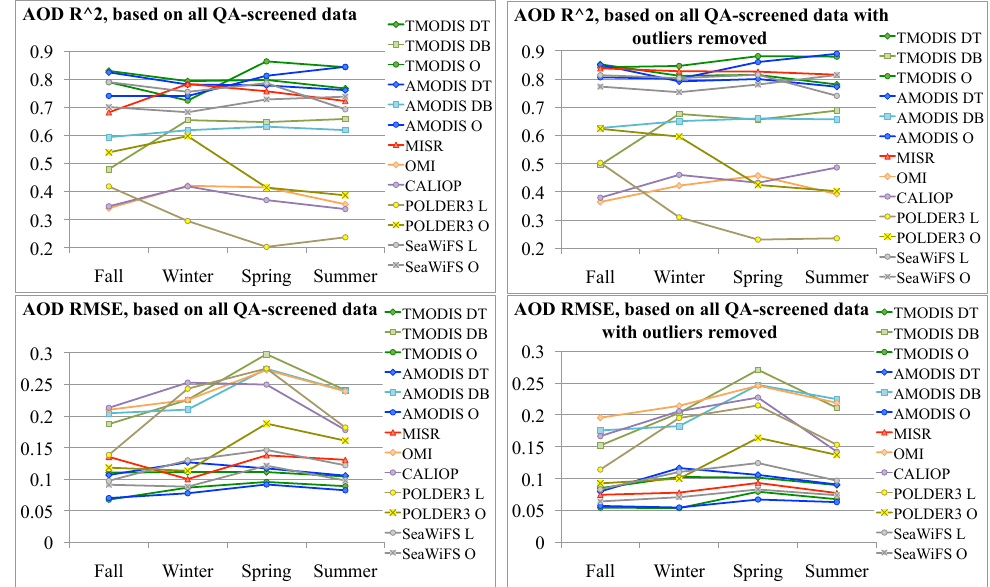
Figure 10. Seasonal dependence of squared linear fit correlation coefficient (R 2 ) and root mean square error (RMSE) statistics between the collocated spaceborne and ground-based (AERONET) observations of AOD, based on the data in Table 3.